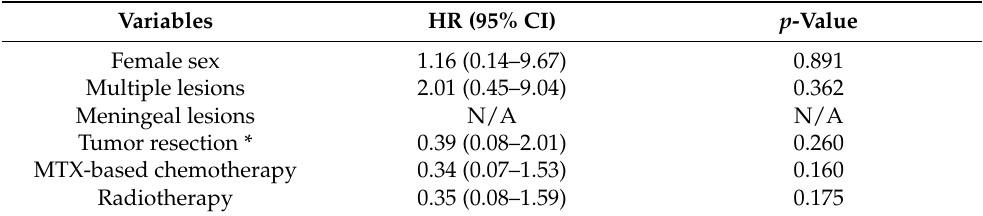
Table 4. Factors related to prognosis for ALK-positive group of primary anaplastic large cell lym- phoma of the central nervous